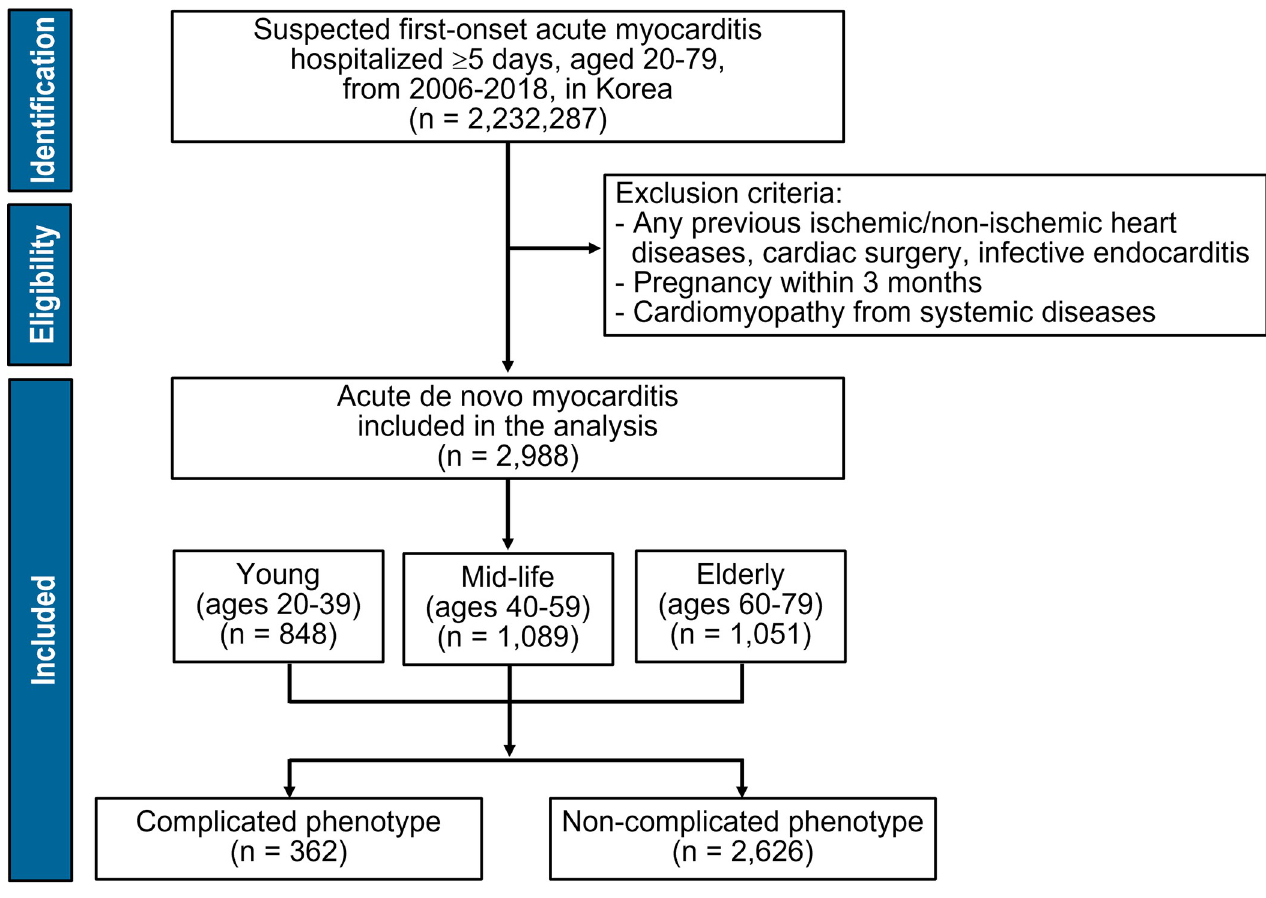
Fig 1. Flow chart of the study